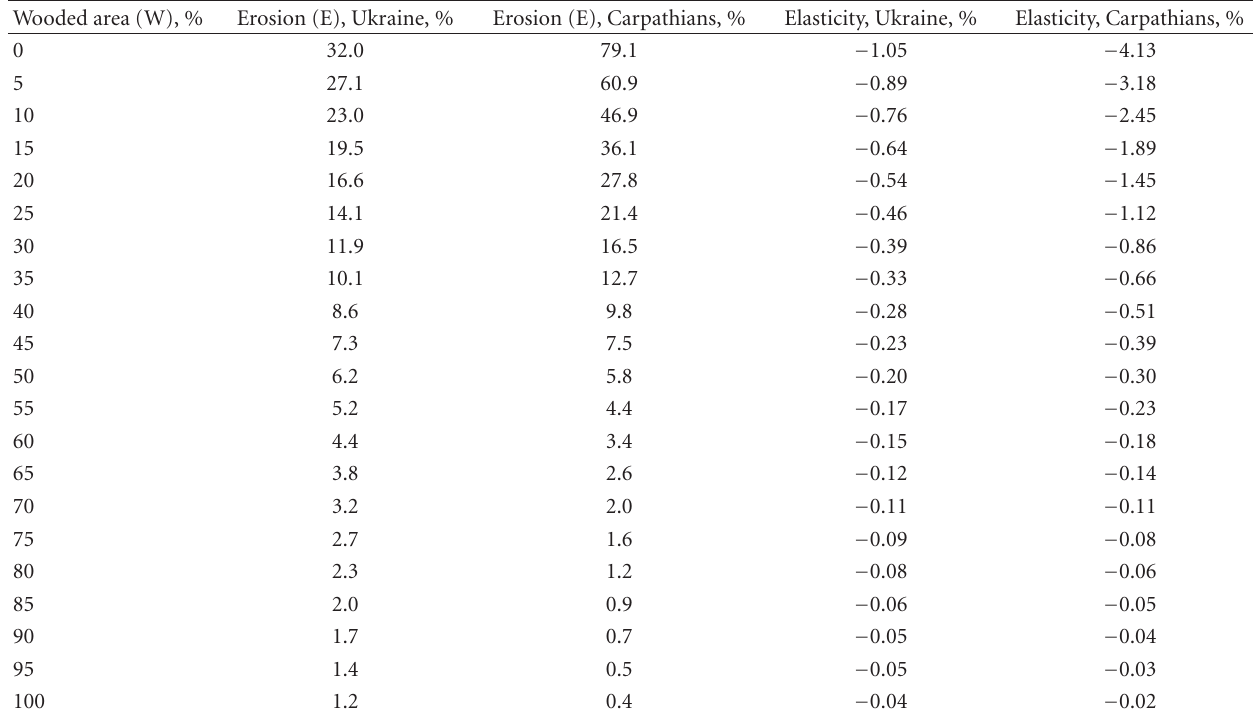
Table 5: Simulated rates of soil